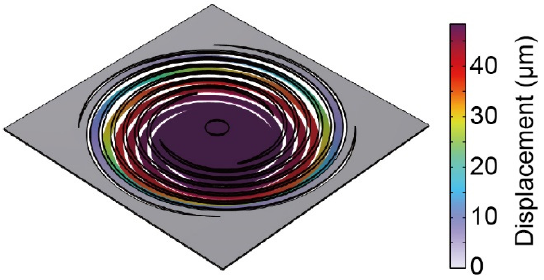
Figure 4. Displacement distribution by simulation of the force plate (iv).